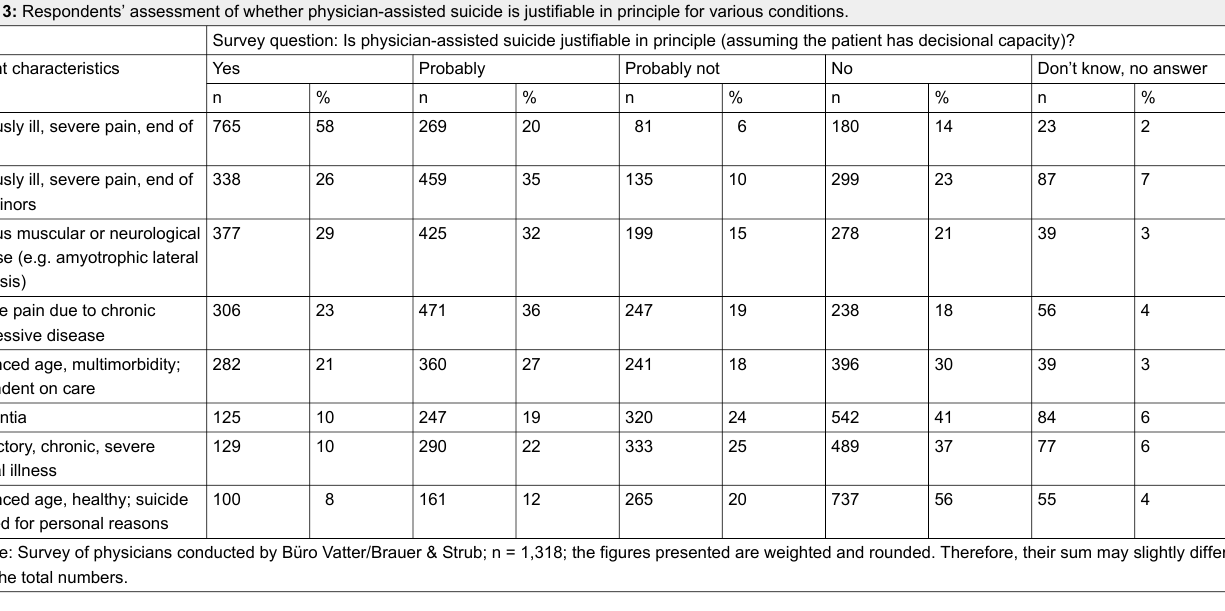
Table 4: Respondents’ position on the end-of-life-criterion in the SAMS Guidelines. Survey question: Should the following condition be maintained in the SAMS